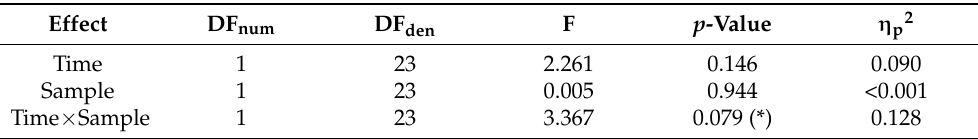
Table 4. Effect of product application on alpha activity. A repeated-measures ANOVA with the factors time (before, after) and sample (AC, PL) was conducted (N = 24).